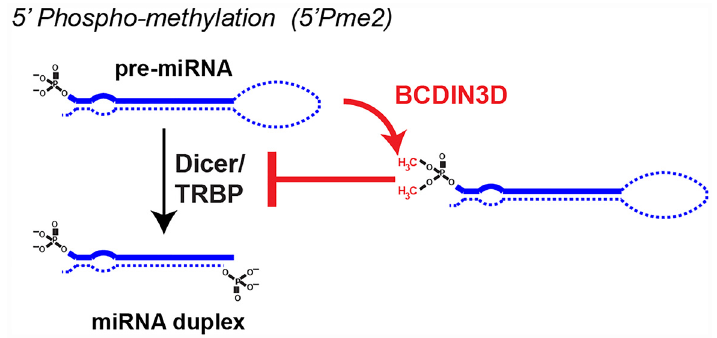
Fig 3. Model for the mode of action of the BCDIN3D RNA methyltransferase on the biogenesis of specific miRNAs. BCDIN3D ’ s enzymatic activity consists in the methylation of the two available oxygen moieties of the 5 0 monophosphate, which removes the 5 0 monophosphate charge and makes it bulkier. This methylation blocks the processing of specific miRNAs [8], possibly through perturbing the interaction of the 5 0 monophosphate with its binding pocket in Dicer